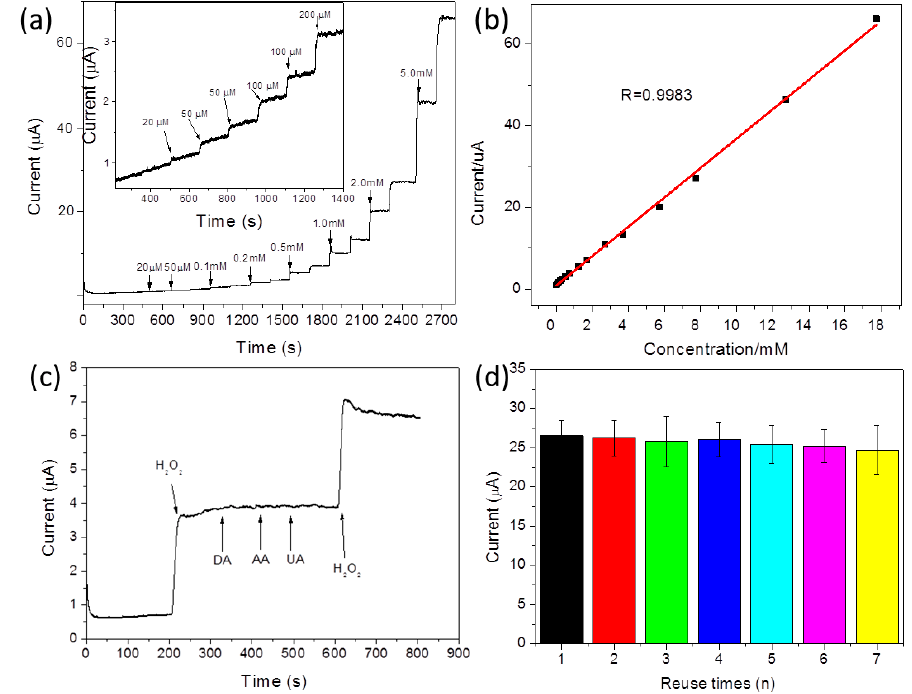
Figure 5. Performance of the H 2 O 2 sensor based on GO–peptide–AgNPs nanohybrids: ( a ) I–T response; ( b ) calibration curve; ( c ) anti-interference capability; and ( d ) reuse stability. Table 1. Comparison of electrochemical H 2 O 2 sensors based on graphene-NPs nanohybrids.